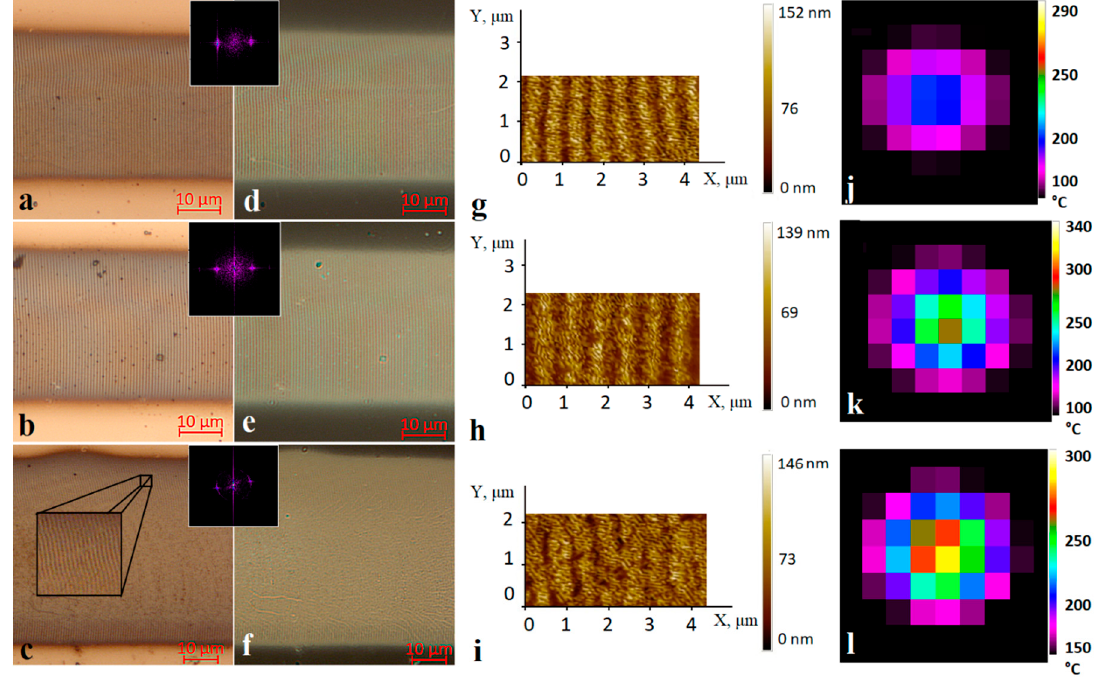
Figure 2. Optical micrographs of the recorded oxide microstructures in reflected ( a – c ) and transmitted ( d – f ) light, AFM images of surface fragments containing laser-induced periodic surface structures (LIPSSs) ( g – i ), and the corresponding thermal images ( j – l ). Insets show 2D-FFT spectra of fragments of the corresponding images (spatial frequencies up to 2 µ m –1 ). The scanning direction by the laser beam in the images ( a – f ) is from left to right. All recordings were conducted with initial partially polarized laser beam. Recording regimes: ( a , d , g , j ) τ = 4 ns, P av = 90 mW, f = 50 kHz, ε = 20 mJ / cm 2 ; ( b , e , h , k ) τ = 4 ns, P av = 140 mW, f = 100 kHz, ε = 24 mJ / cm 2 ; ( c , f , i , l ) τ = 8 ns, P av = 160 mW, f = 50 kHz, ε = 44 mJ / cm 2 . Table 1. Physical and optical characteristics of titanium and BK7 glass.